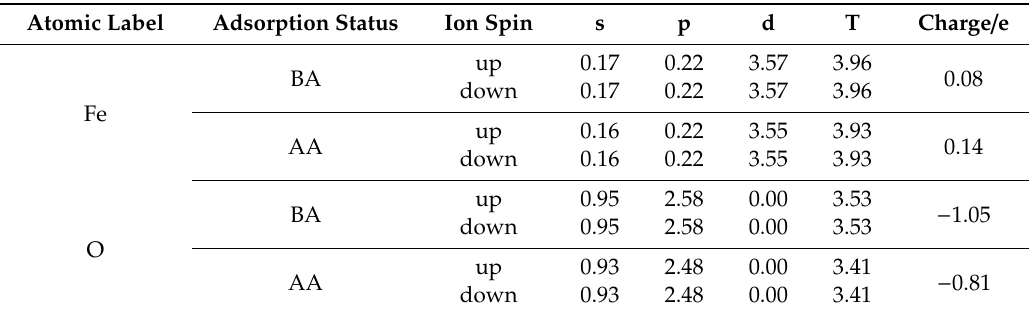
Table 6. Mulliken charge populations of atoms for H 2 O /